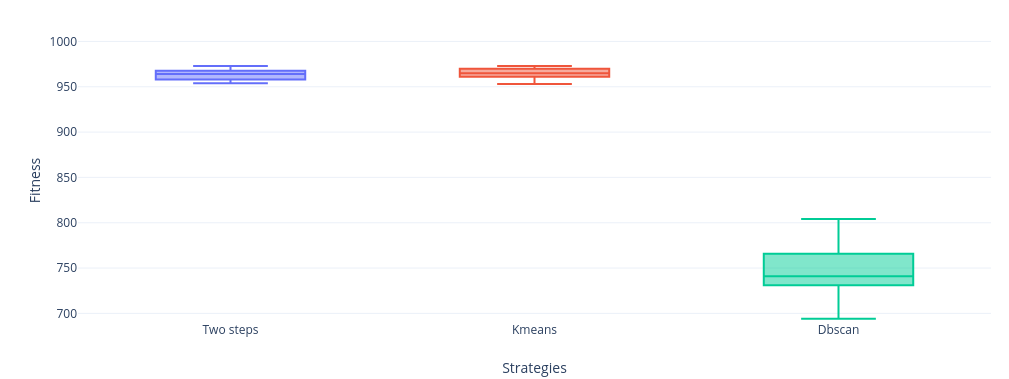
Figure 23. Instance f8 distribution.